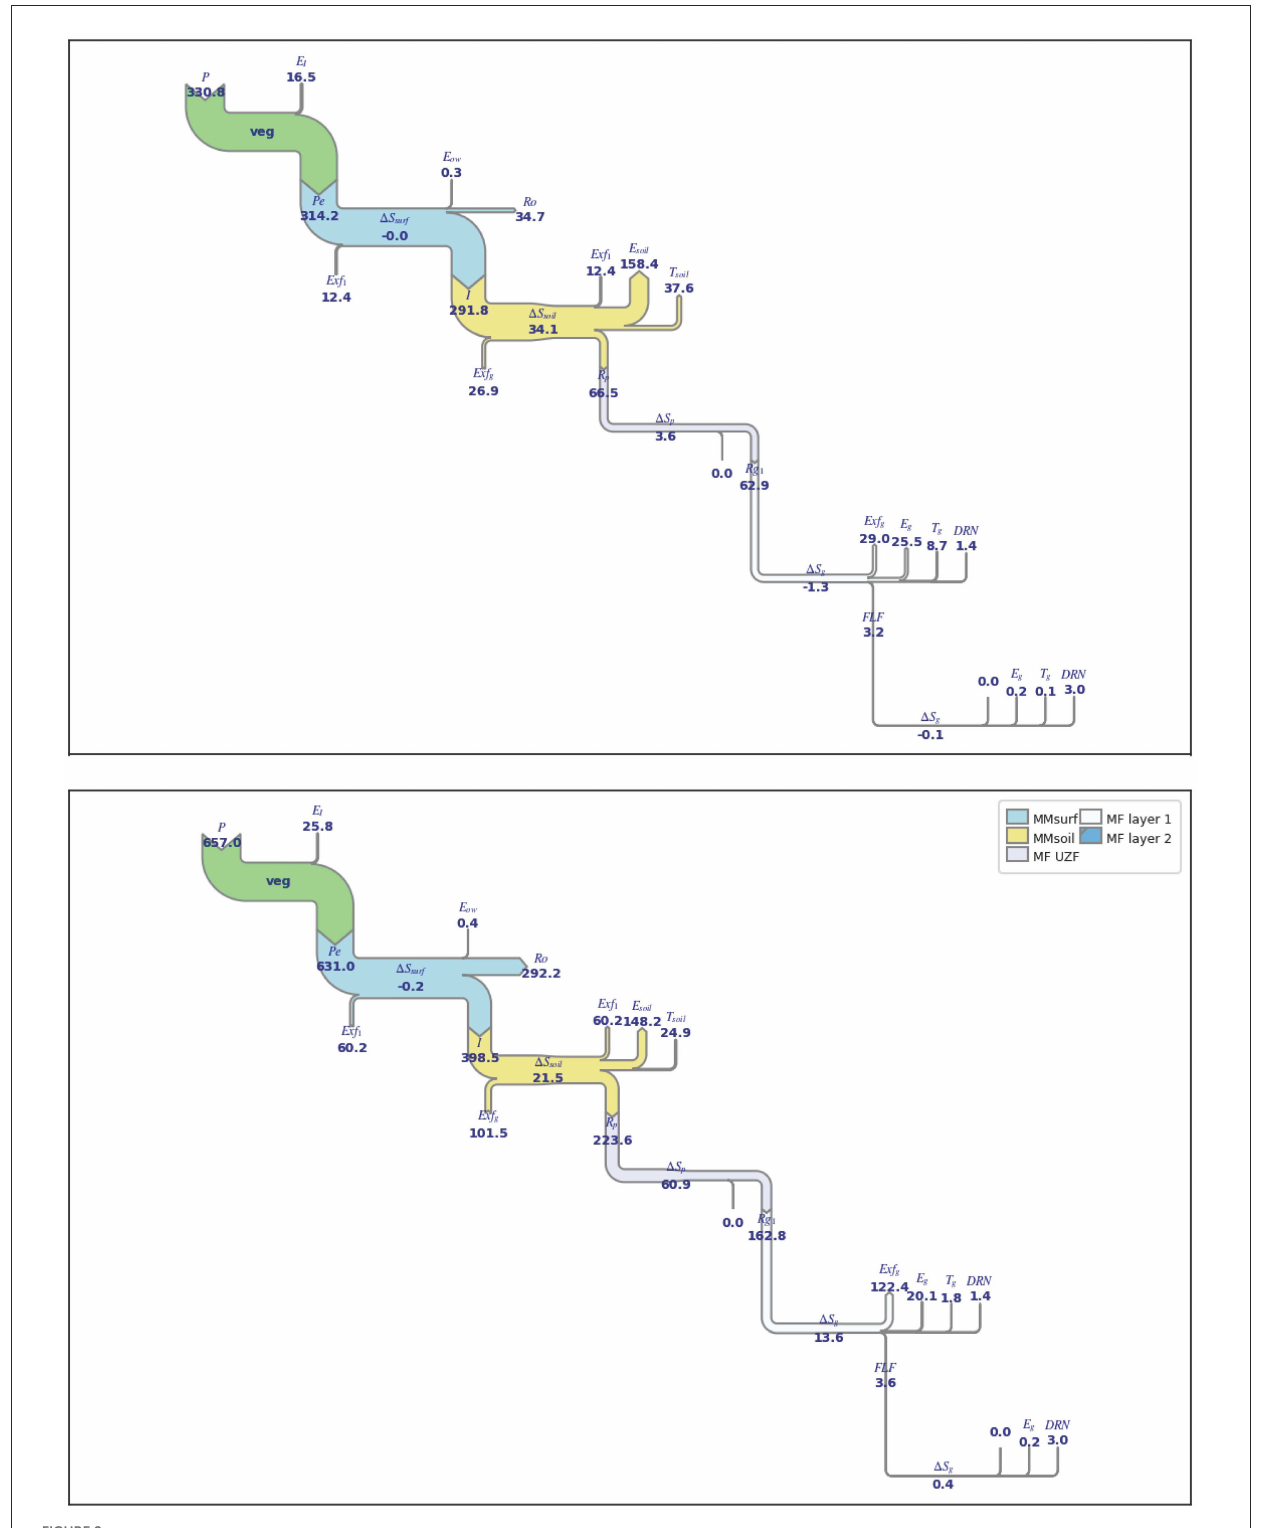
FIGURE8 Sankey diagrams representing the yearly water balance at the catchment scale for dry year 2012 (top) and medium-wet year 2013 (bottom) . Units in mm.y − 1 , labels of water fluxes lower than 1 E − 2 mm.y − 1 not shown. 1 —change in storage, DRN —lateral groundwater outflow ( Qo ) at the catchment outlet simulated using the Drain Package of MODFLOW. See Figure 2 for other